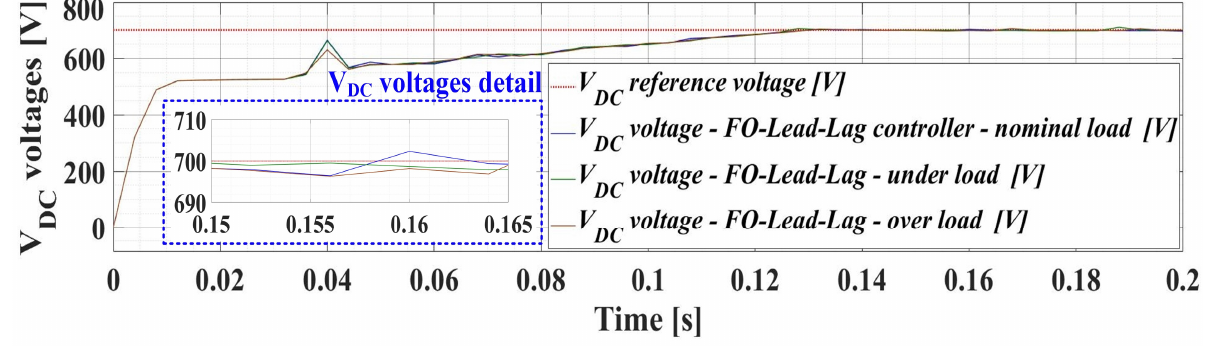
Figure 12. V DC voltages time evolution of the UPQC-APF control system based on FO-Lead-Lag controller in case of nonlinear load.